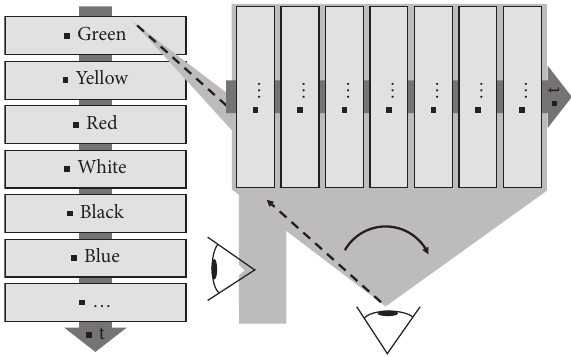
Figure 2: The following CamShift algorithm mainly uses Hue information in the HSV